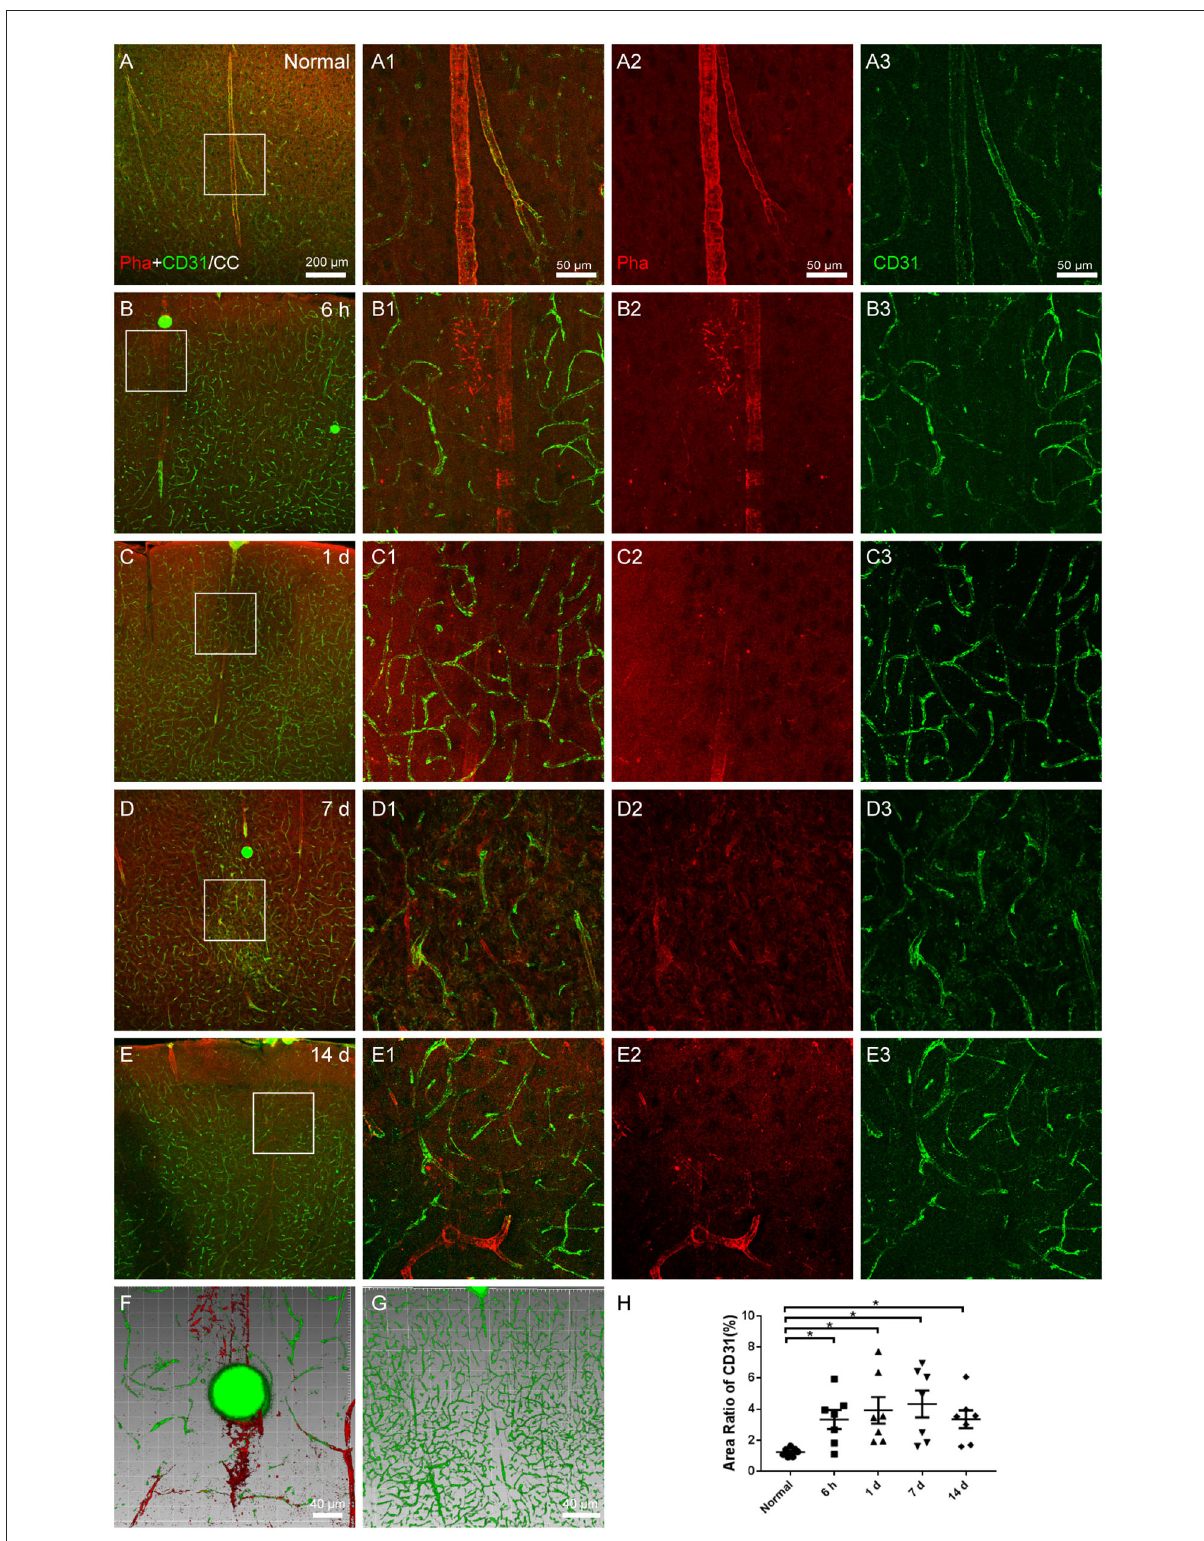
FIGURE3 The vascular occlusion in the cerebral cortex. (A–E) The representative photographs from the cerebral cortex (CC) at the group of normal, 6h, 1, 7, and 14 days, showing phalloidin (red)-labeled arteries and CD31 (green, Alexa Fluor 488)-labeled capillaries. (A1–E1) Magnified